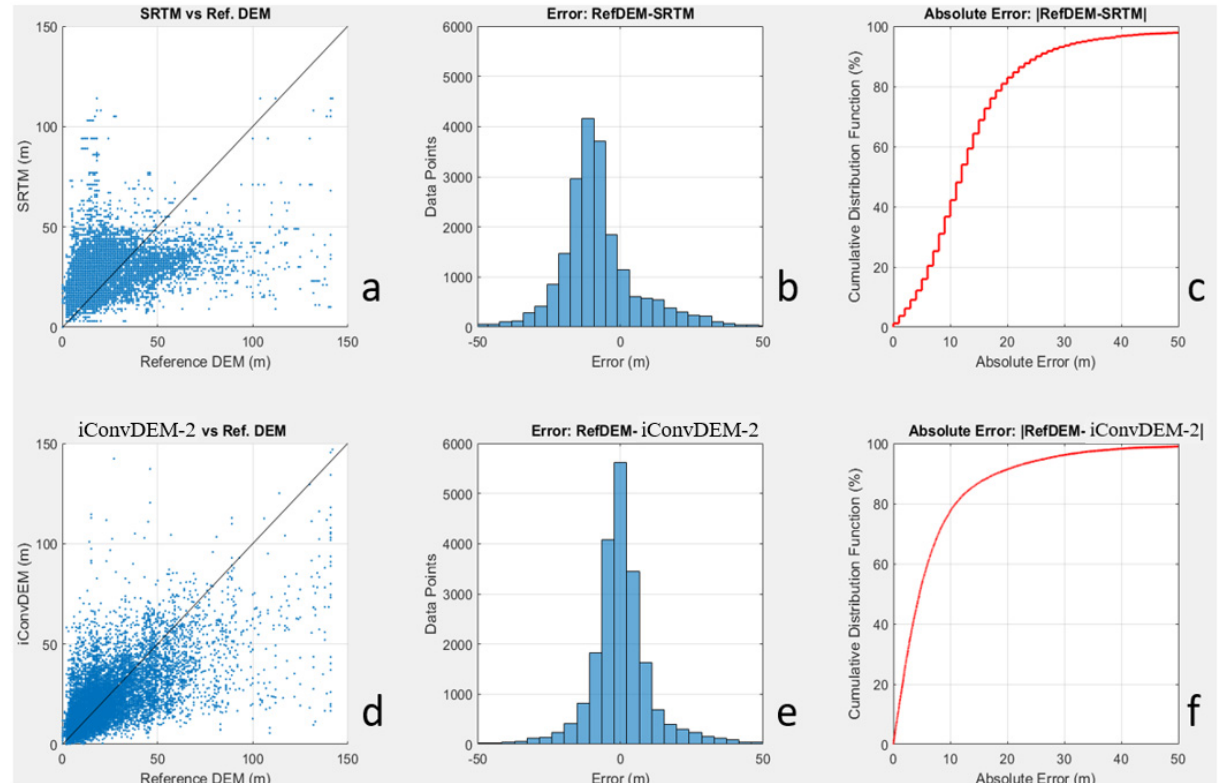
Figure 12. Statistical analysis of sub-area within the test site in Orchard Road, Singapore, versus reference DEM, of: ( a ) elevations of SRTM DEM, ( b ) errors of SRTM DEM, ( c ) absolute errors of SRTM DEM, ( d ) elevations of iConvDEM-2, ( e ) errors of iConvDEM-2 and ( f ) absolute errors of iConvDEM-2.